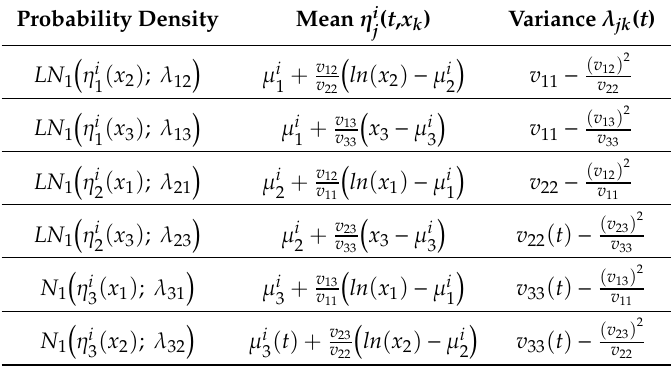
Table 6. Mean and variance of conditional probability density functions with one predictor. Probability Density